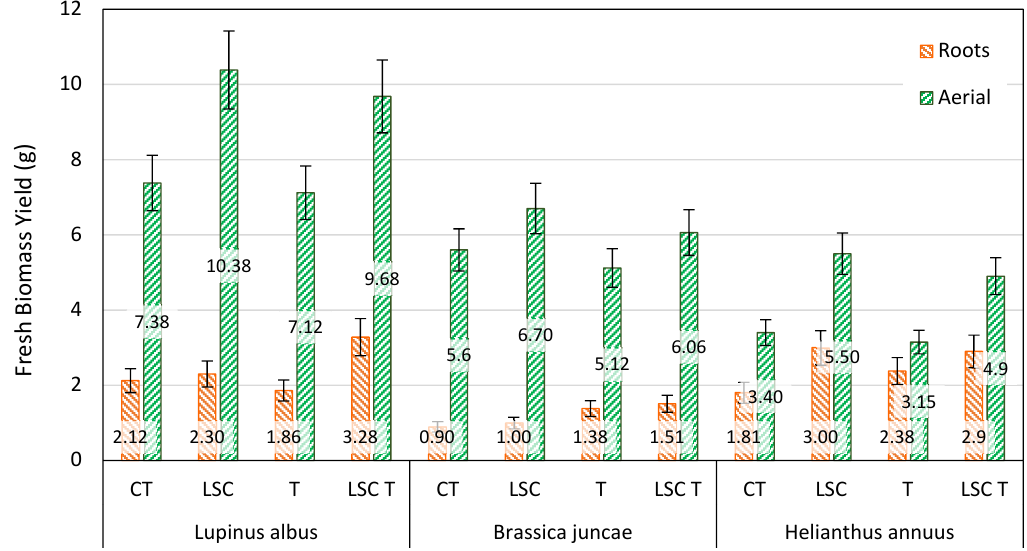
Figure 9. Fresh biomass production of shoots and roots. LSC the plants grown under the red panels and T the plants that have been treated with Ethylene Diamine Tetraacetic Acid (EDTA). Values are reported as mean ± standard deviation.